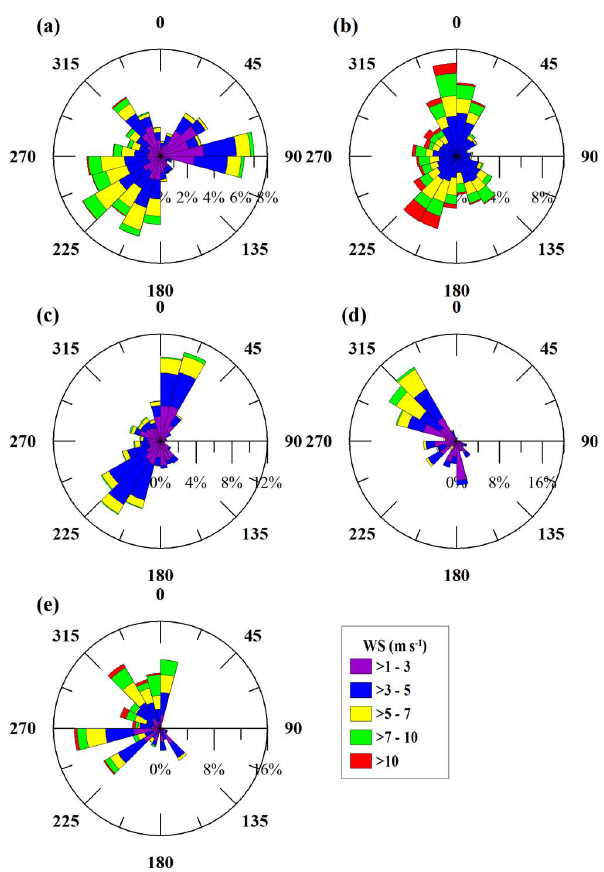
Fig. 2. Wind rose plots for the five monitoring sites with 36 com- pass directions along with wind speed distribution: Harrow (a) , Ridgetown (b) , Bear Creek (c) , Egbert (d) , and Toronto (e) .